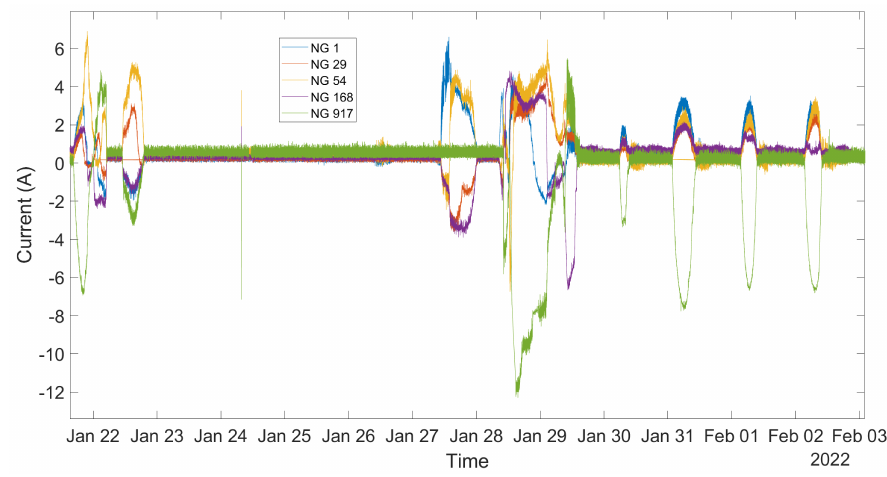
Figure 33. Exchanged currents on the microgrid deployed in Ambohimena during a rainy period.